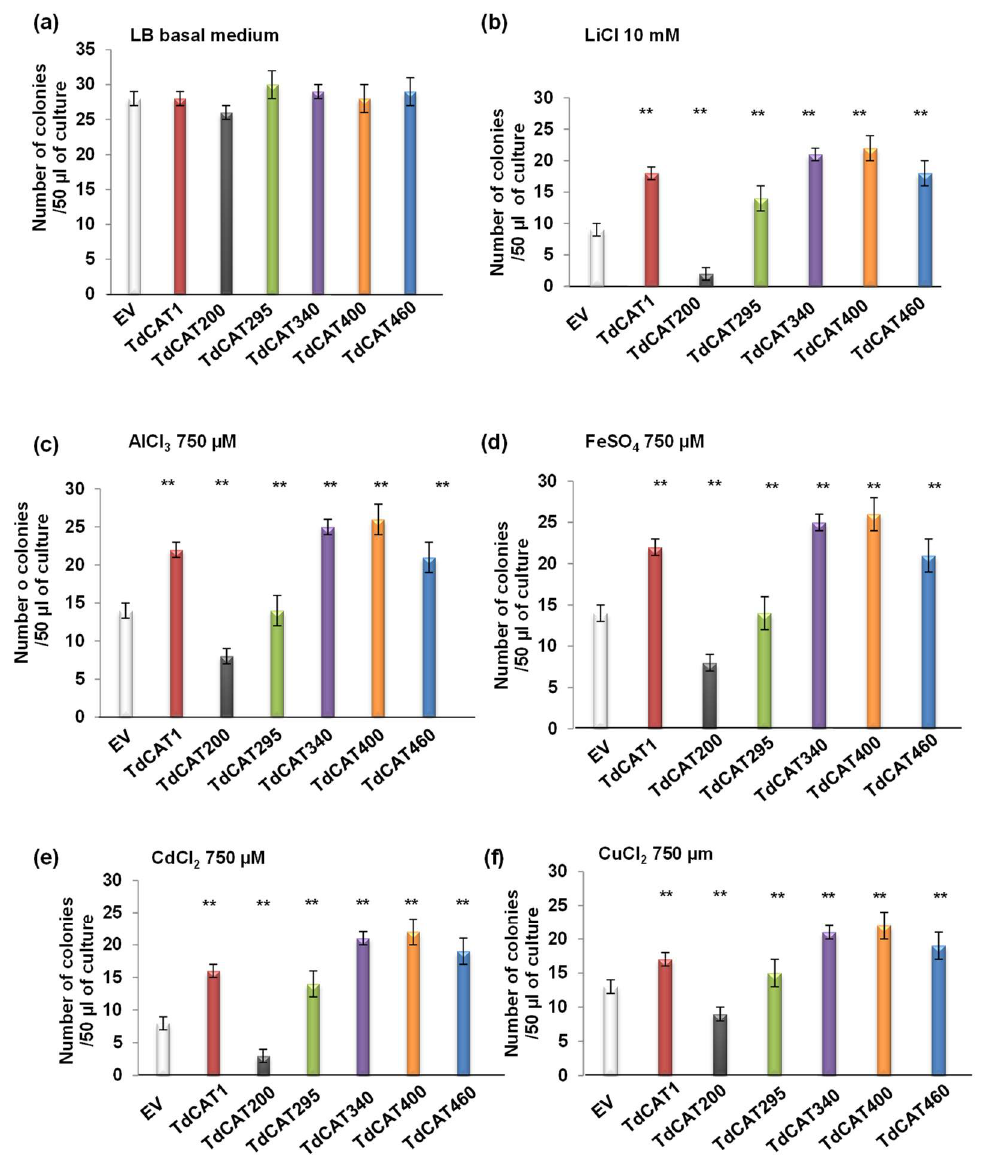
Figure 9. Percentage of cells’ viability under control and heavy metal stress conditions. E. coli cells transformed with the empty vector (pET28a) or with the recombinant vectors (pET28a + TdCAT1 or its derivatives) were grown for 24 h under normal growth conditions (LB medium, ( a )) or after the addition of 10 mM LiCl ( b ), 750 µ L AlCl 3 ( c ), 750 µ L FeSO 4 ( d ), 750 µ L of CdCl 2 ( e ), or 750 µ L CuCl 2 ( f ), Ev: Empty vector. Data presented are means of at least three independent experiments ± S.E. Mean values that were significantly different at p < 0.01 from each other are marked with asterisks (**). (**) indicates value significantly different from the control. Statistical significance was assessed by applying the student t-test at p < 0.01.